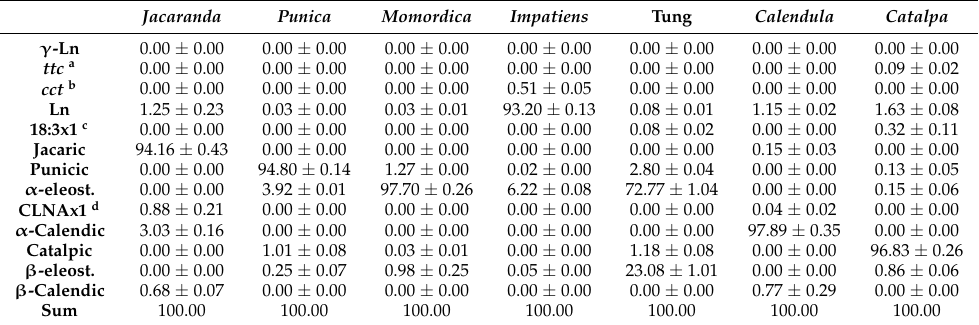
Table 5. 18:3 Isomer distribution. Entries are percentages of total integrated 18:3 FID signal and are the means of three independent determinations. Uncertainties are 95% confidence limits based on the t -distribution with 2 degrees of